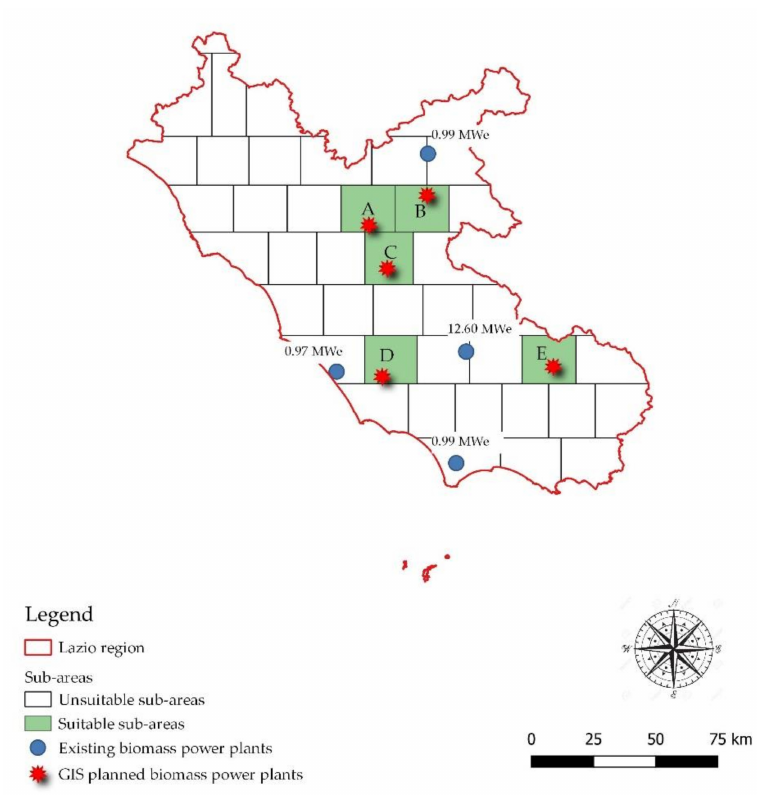
Figure 4. Sub-areas identified as suitable for the implementation of the pruning supply chain, existing biomass power plants in the region (blue dots), and location of the theoretical plant for each sub-area (red stars).